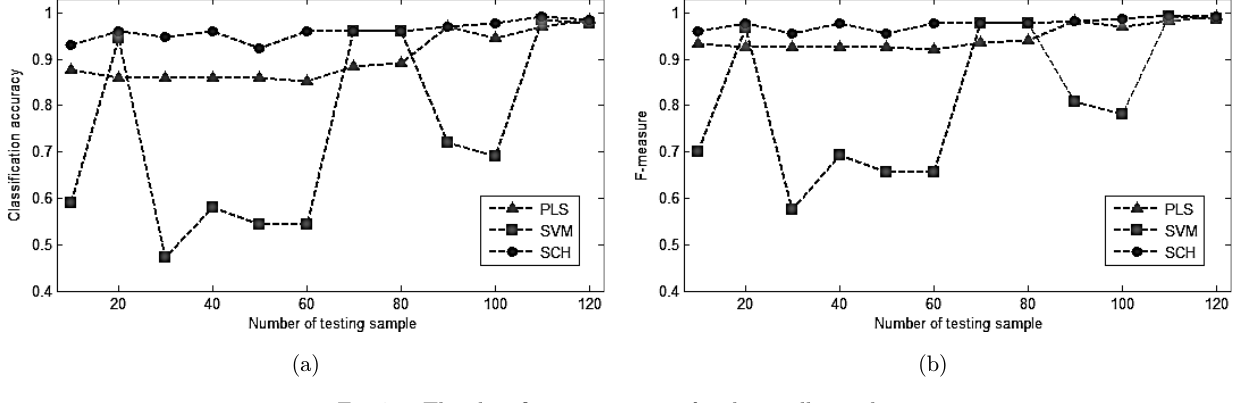
Fig. 7. The classi¯cation accuracy for the small